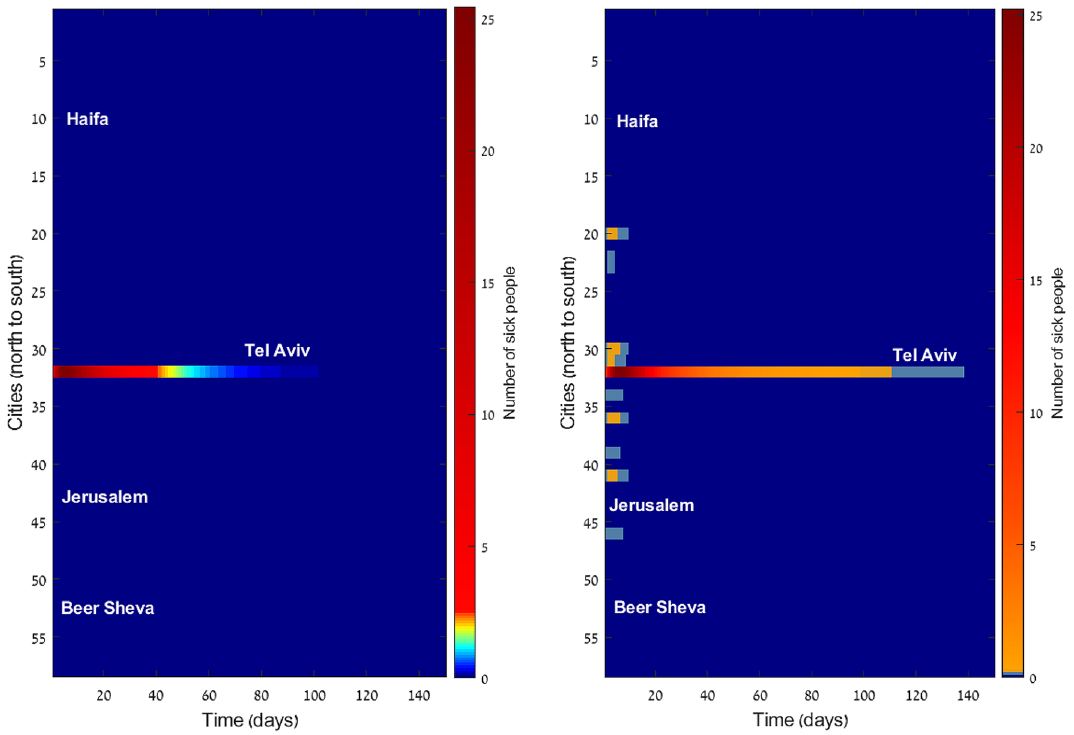
Figure 5. Number of sick individuals in 55 locations (sorted from north to south). Infection rate is zero. Left: the accurate reverse commuting method, morbidity is limited to Tel-Aviv. Right: naïve approach, morbidity incorrectly diffuses to other